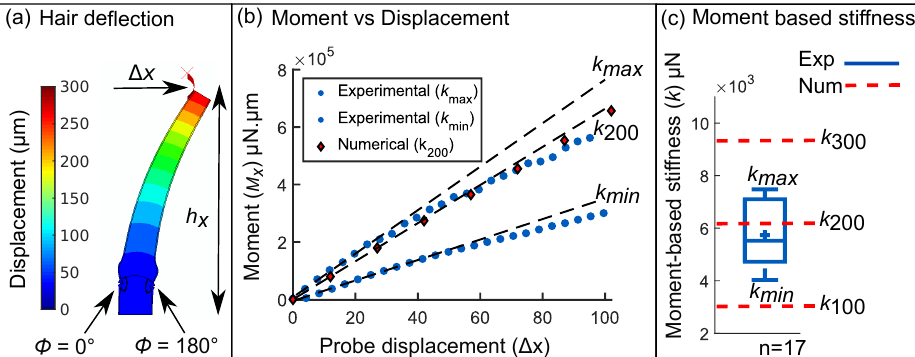
Figure 4. ( a ) FEM simulation output showing the deflection of a sensory hair using a displacement up to ∆ x = 300 µ m. ( b ) Moment vs. displacement curves (experimental, blue circles) shown for two force-displacement tests and (numerical, red diamonds) for E cw = 200MPa. The initial linear slopes k max , min give the lowest and highest moment-based stiffness values found in (n = 17) tests. ( c ) Boxplot of the moment vs. displacement slopes k obtained from 17 experimental tests. The middle line denotes the median value and the mean is shown with a ‘+’ sign. Numerical outputs are denoted by dashed red lines for E cw = 100, 200, and